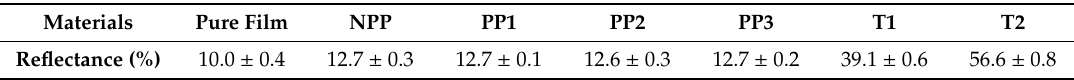
Figure 7. Di ff use reflectance spectra of the black substrate, pure thin film, and thin films with PP3, T1, T2, PP3@T1, and PP3@T2 particles. Table 2. Di ff use reflectance of the pure thin film and thin films with only PMMA or TiO 2 particles at 600 nm.